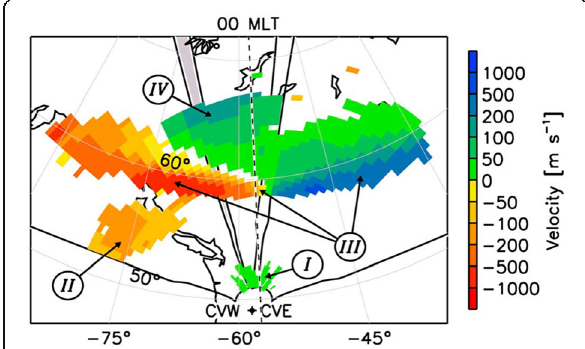
Fig. 4 A plot of Doppler velocity against radar beam and range from CVE and CVW radars. This figure shows Doppler velocity observations (positive toward the radar) for one scan of data from CVW and CVE and indicates four separate regions of ionospheric scatter indicated by the number I — meteor scatter, II — low-velocity ionospheric scatter from the sub auroral region, III — scatter from a SAPS, and IV — low-velocity ionospheric scatter from the auroral regions. Reproduced from Fig. 2 of Clausen et al.